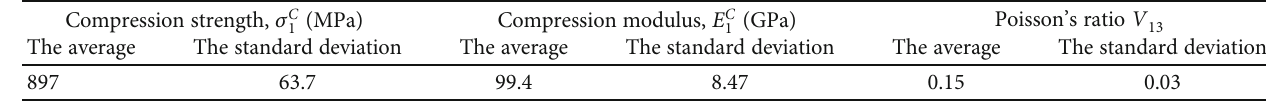
Table 2: Longitudinal compression properties of fi ber